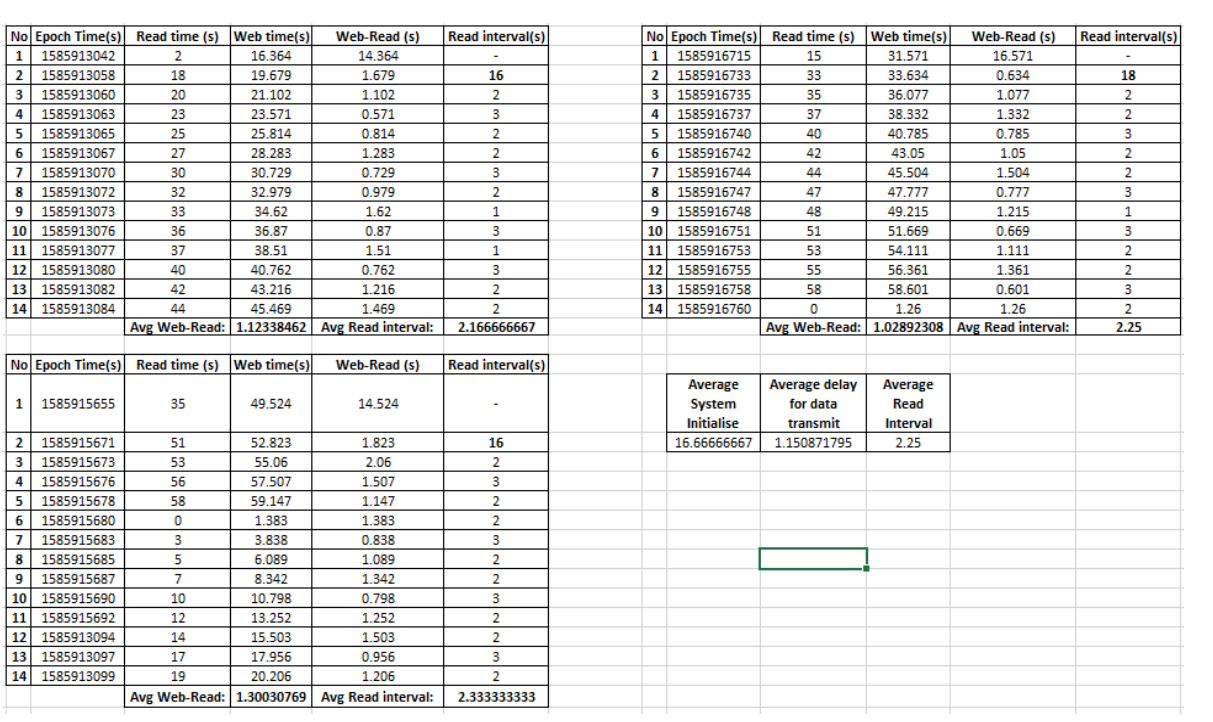
Figure 23. Data analysis for read time and web time.